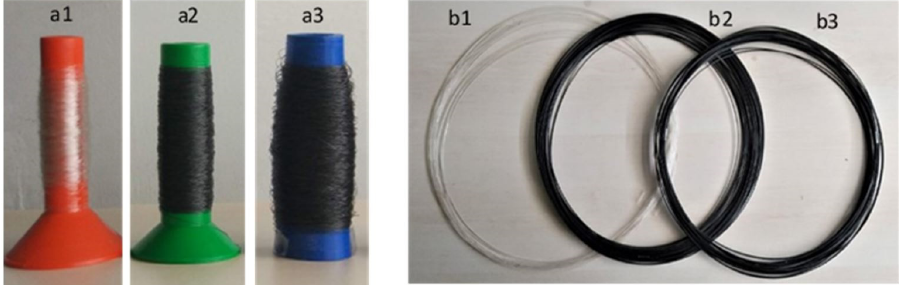
Figure 8. Composite filaments: FilText ( a1 —PLA; a2 —PLA+0.5[(f-EG)+Ag]; a3 —PLA+2[(f-EG)+Ag]) and Fil3D ( b1 —PLA; b2 —PLA+0.5[(f-EG)+Ag]; b3 —PLA+2[(f-EG)+Ag]). and Fil3D ( b1 —PLA; b2 —PLA+0.5[(f-EG)+Ag]; b3